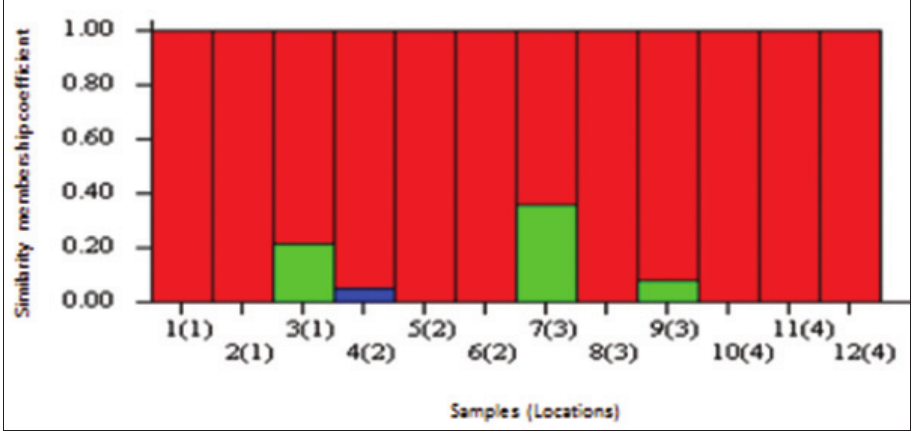
Figure-4: Amplified fragment length polymorphism marker-based structure bar plot graph of K=3, for 12 samples in 4 locations. Samples are ordered by group assignment and locations are indicated between brackets. Table-2: Genetic diversity and DNA polymorphism based on AFLP bands. Parameter/location